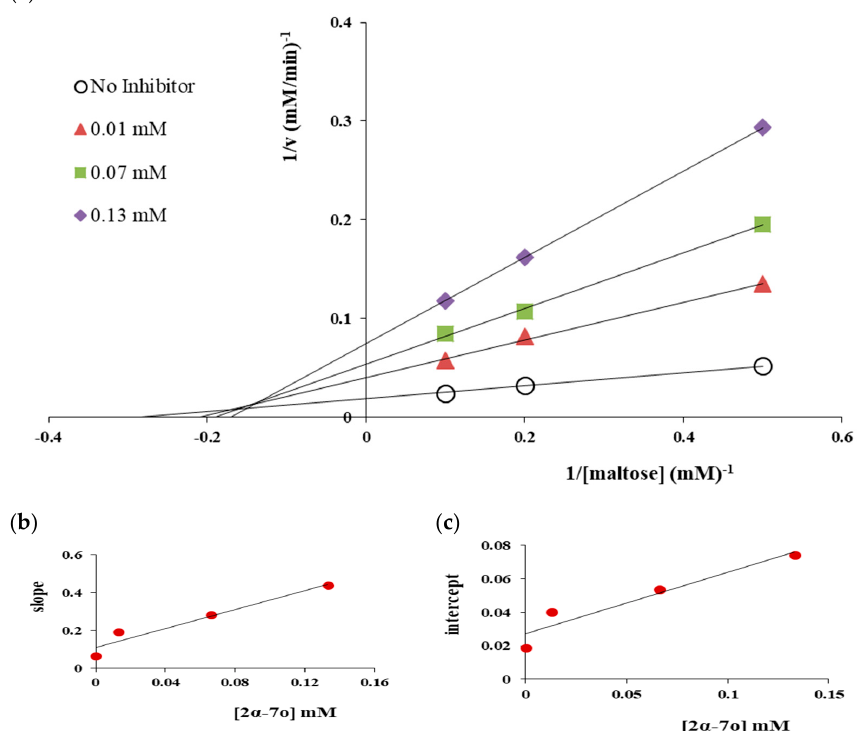
Figure 11. Lineweaver–Burk plots for inhibitory activity of 2 α -7o against rat intestinal maltase ( a ). Secondary replots of ( b ) slope vs. [I] and ( c ) intercept vs. [I] from a primary Lineweaver–Burk plot for the determination of K i and K’ i , respectively.